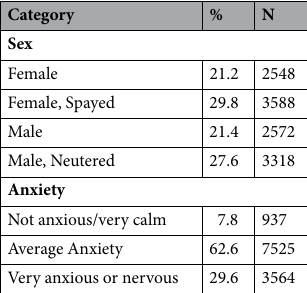
Table 1. Categorical Demographic